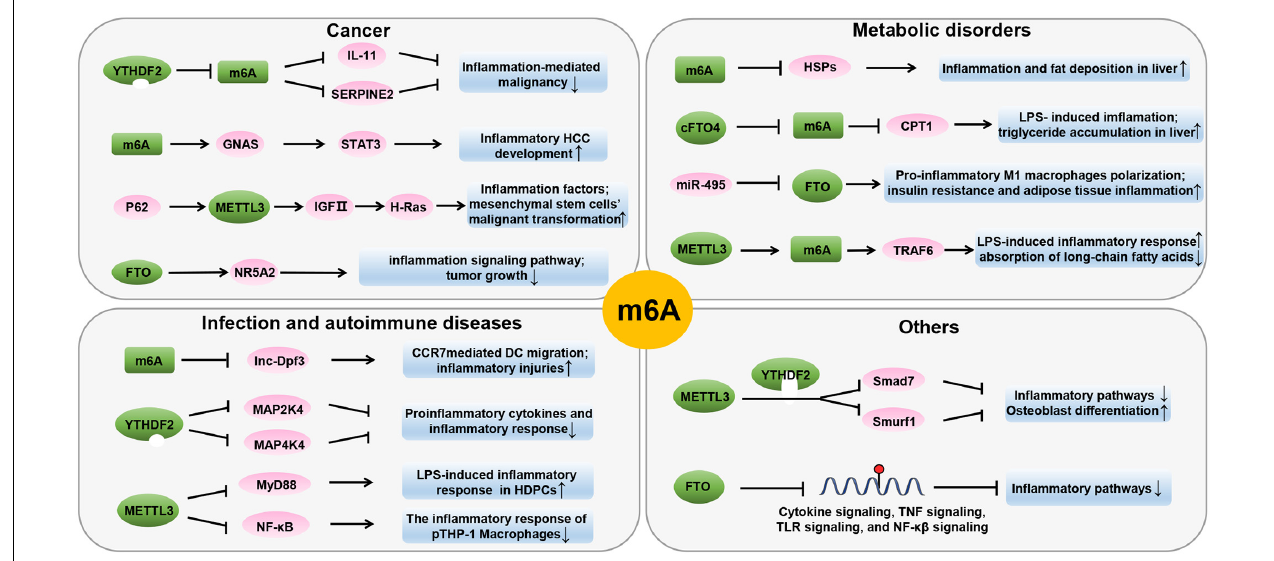
FIGURE 3 | Role of m6A in inflammatory processes of various diseases states. m6A modification affects inflammation by regulating inflammation-related genes. RNA methylation is linked through numerous mechanisms and present in various inflammatory disease states, including autoimmunity, infection, metabolic diseases, and